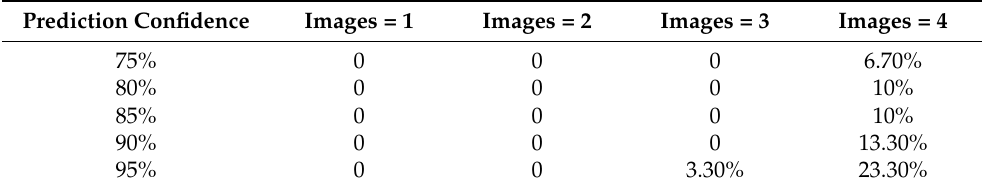
Figure 7. A false positive was not considered a defect since it was detected by the algorithm only on the first and second images (surrounded by blue and yellow bounding boxes), and was not detected on the third image (red circle). Table 3. False negative percentages with consecutive image constraints on 30 defective-gear scans. “Images = X” represents the number of sequential images of the gear scan where a defect was predicted, probably greater than the corresponding prediction